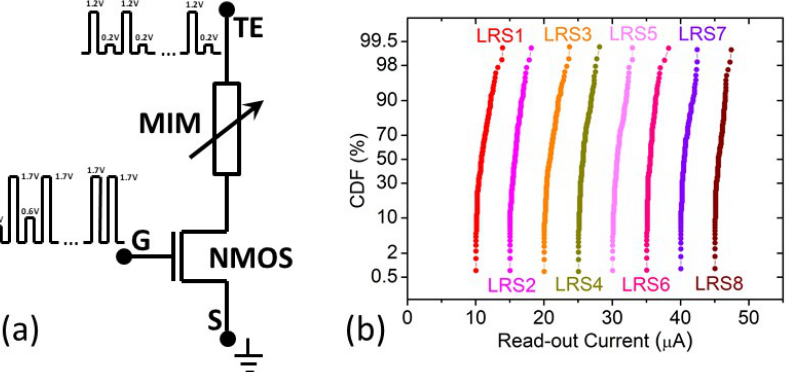
Figure 2. Circuit schematic of the 1T1R cells with the voltage waveforms applied on each terminal during IGVVA programming operations ( a ) and CDFs of the readout currents measured for eight conductive levels ( b ).